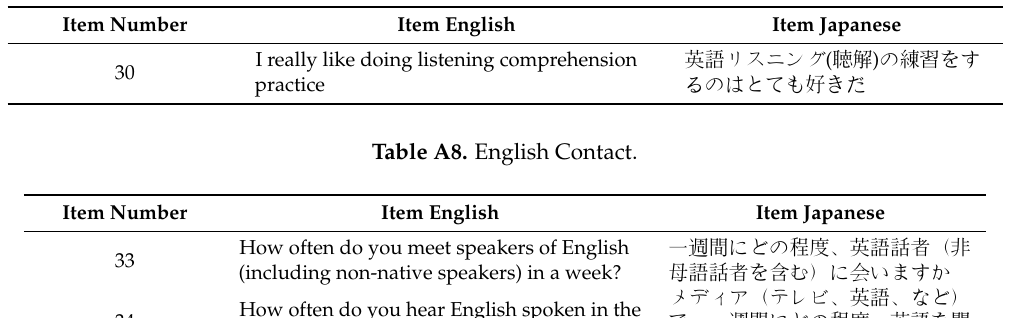
Table A7. Attitudes towards Listening Comprehension Practice in the L2.